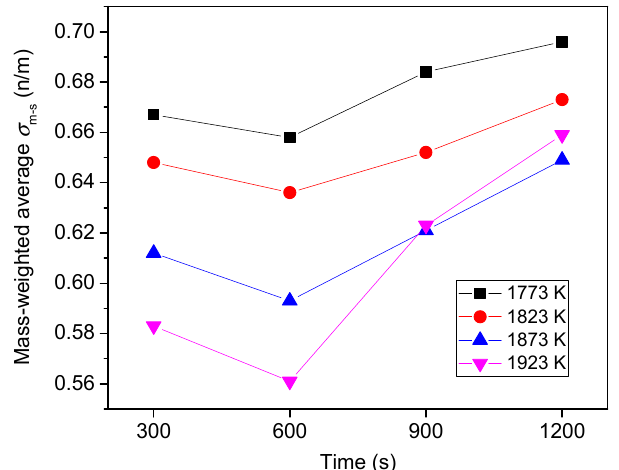
Figure 14. Effect of heating temperature on mass-weighted average coefficient of interfacial tension Figure 14. E ff ect of heating temperature on mass-weighted average coe ffi cient of interfacial tension between the molten slag and the molten manganese. between the molten slag and the molten